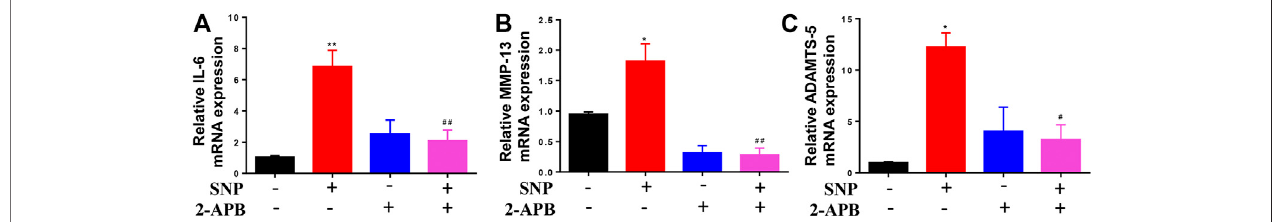
FIGURE 4 | 2-APB downregulates IL-6, MMP-13 and ADAMTS-5 mRNA expression in SNP-induced chondrocytes (A – C) qRT-PCR analysis of 2-APB on SNP- induced IL-6, MMP-13 and ADAMTS-5 mRNA expression in chondrocytes. Chondrocytes were seeded in 6-well plates cultured for 24 h, then treated with 2-APB (100 μ M) and SNP (0.5 mM) for 12 h. Values are presented asmean ± SEM. n (cid:2) 3, * p < 0.05, ** p < 0.01, compared with control group; # p < 0.05, ## p < 0.01, compared with SNP group.